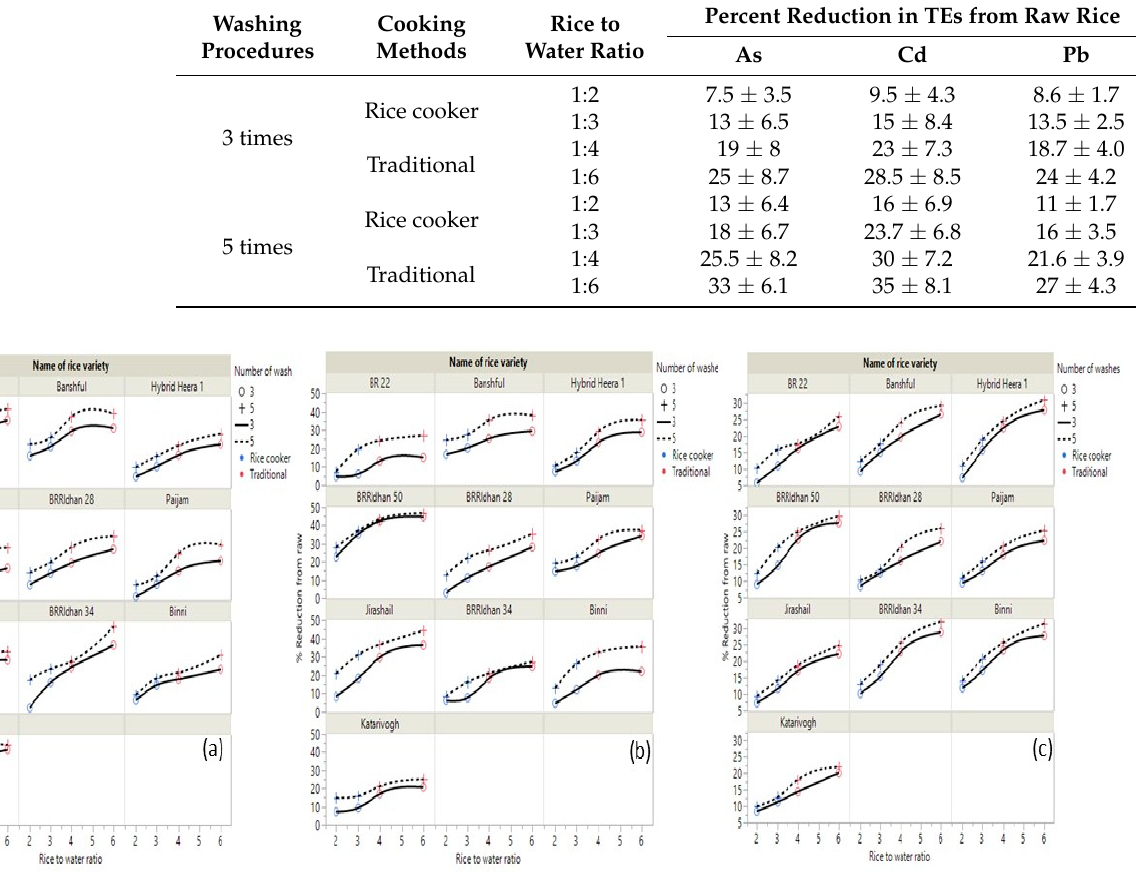
Figure 2. Effect of various cooking methods on percentage reduction in ( a ) As, ( b ) Cd, and ( c ) Pb from different rice brands.